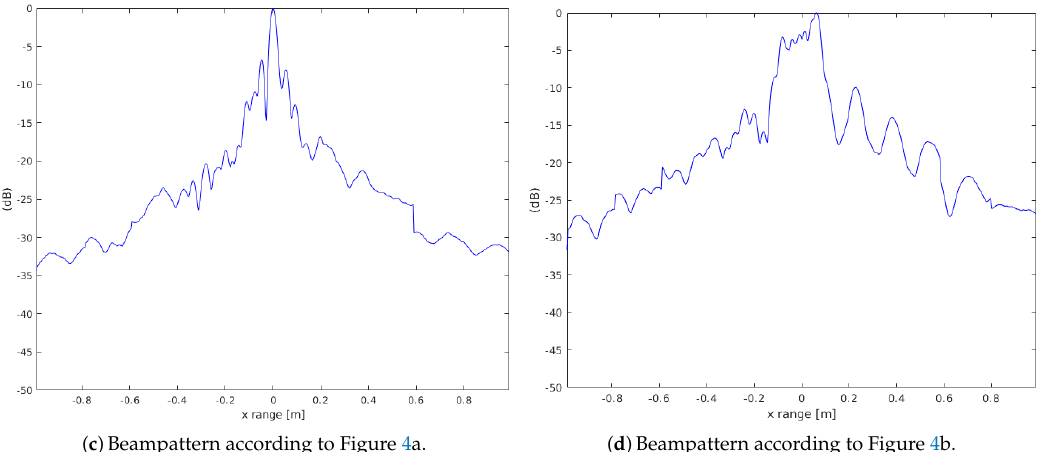
and r w = 1.4 · c . 2 f 0 2 f 0